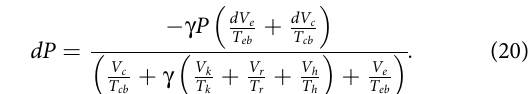
Substituting Eqs 18 and 19 into Eq. 16 and rearranging yields Eq.